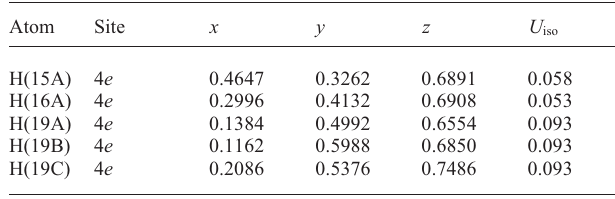
Table 3. Atomic coordinates and displacement parameters (in Å 2 )